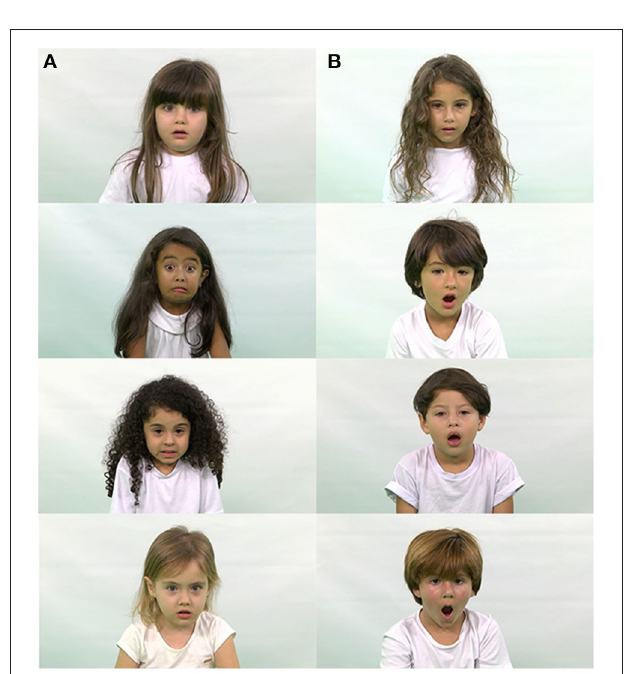
FIGURE 3 | Examples of ChildEFES database images. (A) Fear (B) Surprise.